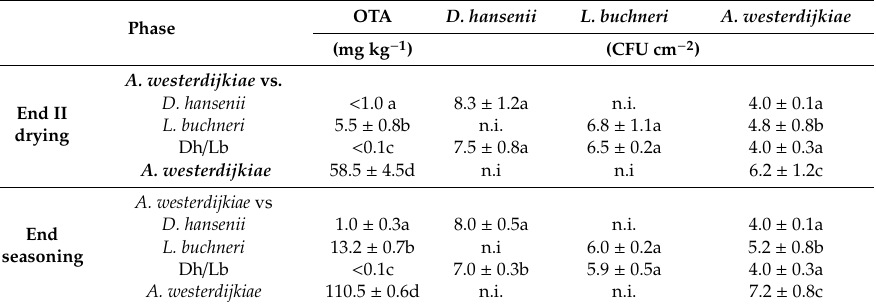
Table 7. Mean production of Ochratoxin A by A. westerdijkiae in control and selected D. hansenii and L. buchneri co-inoculated at the end of second drying and seasoning stages and their fate during the seasoning of short seasoning dry cured ham. OTA D. hansenii L. buchneri Phase